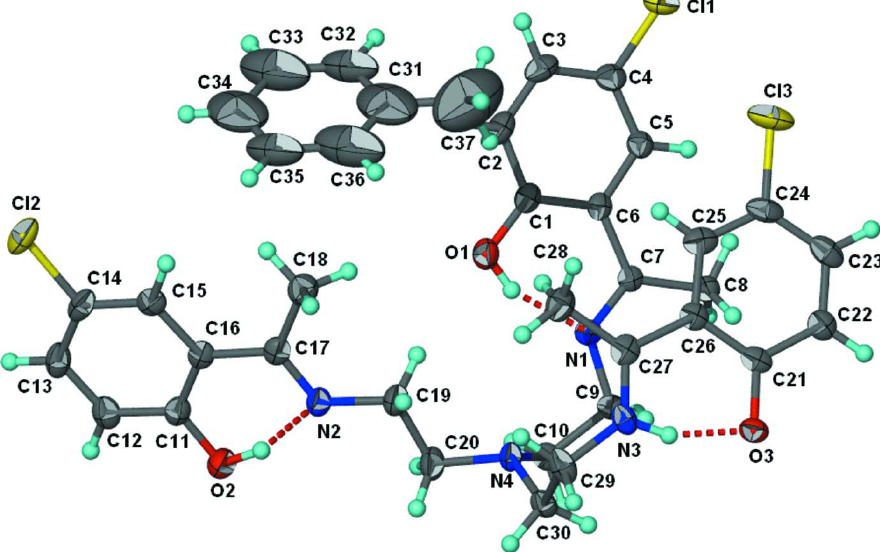
Figure 1 Anisotropic displacement plot (Barbour, 2001) of C are drawn as spheres of arbitrary